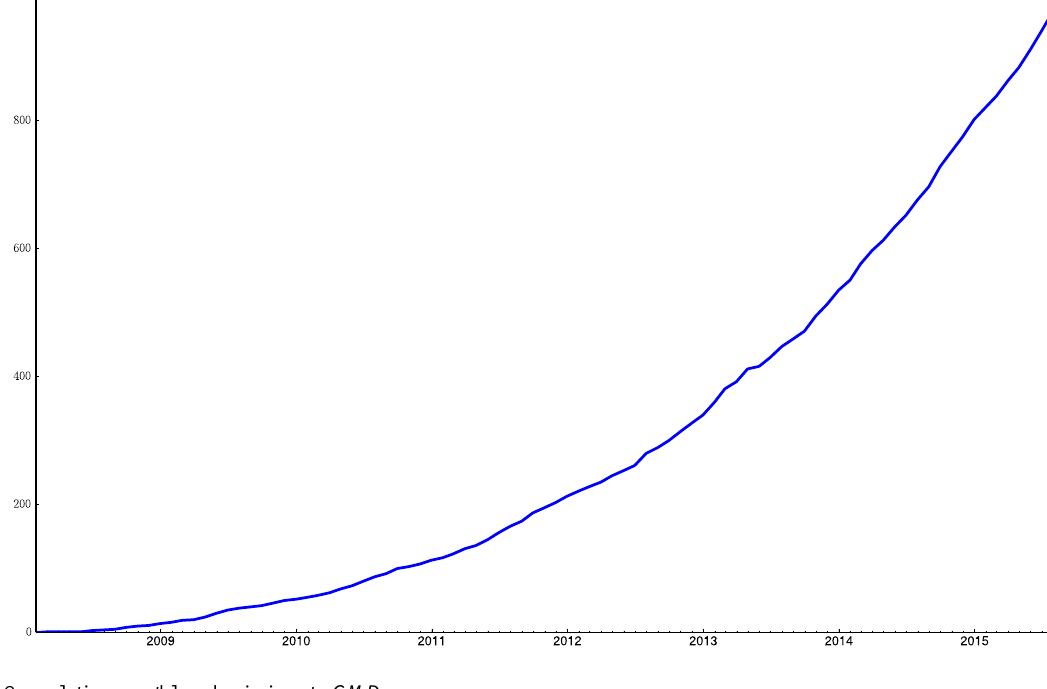
Figure 1. Cumulative monthly submissions to GMD .